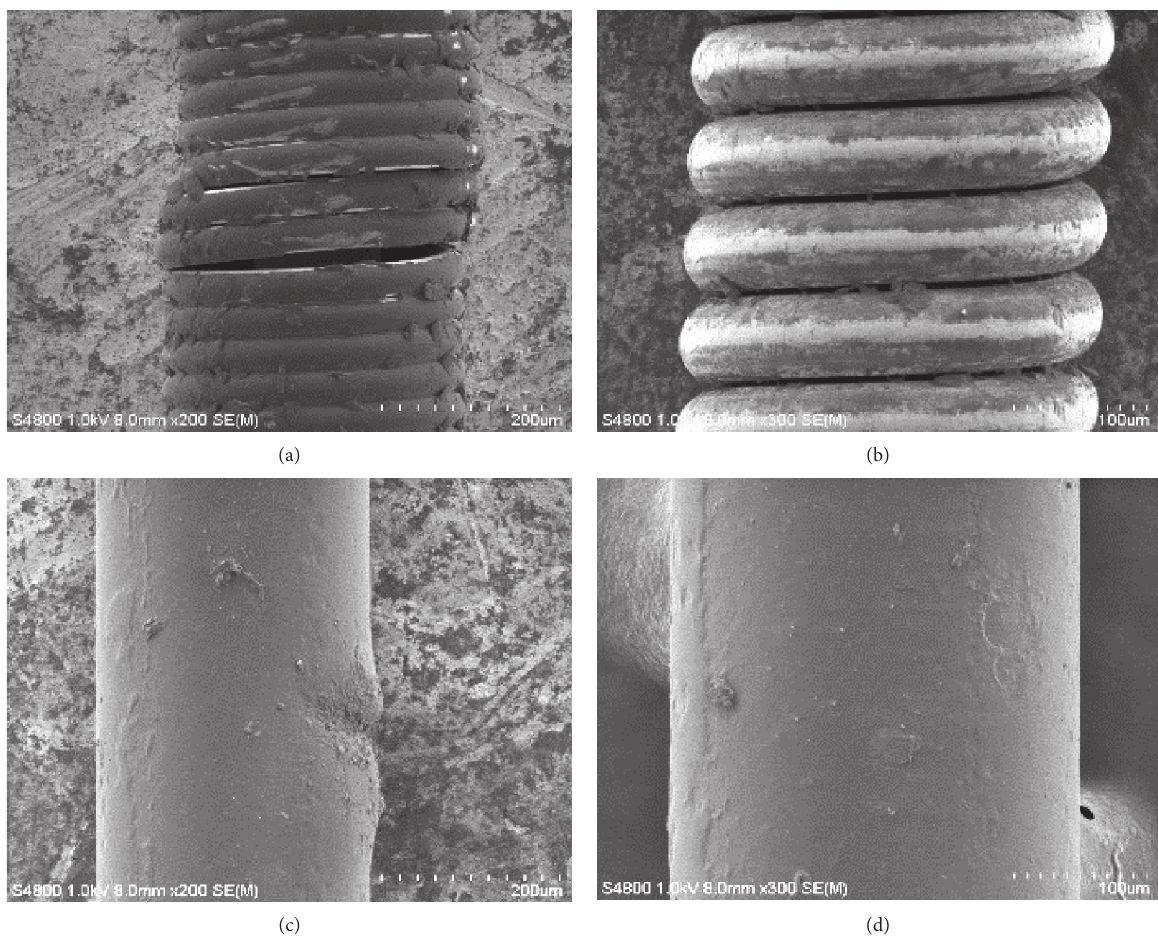
Figure 3: Representative SEM images of coil structure of Runthrough NS wire group (a), coil structure of the HT BMW Universal II wire group (b), jacket structure of the HT BMW Universal II wire group (c), and jacket structure of the HT Whisper group